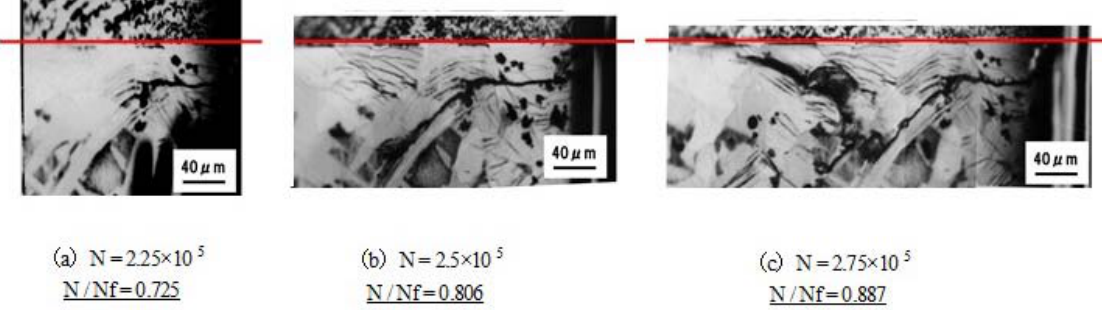
Figure 4. The micrographs of crack propagation in the S45C-SPDSS interface for various number of cycles. Red line indicates the bonded interface. Lower part of red line is S45C